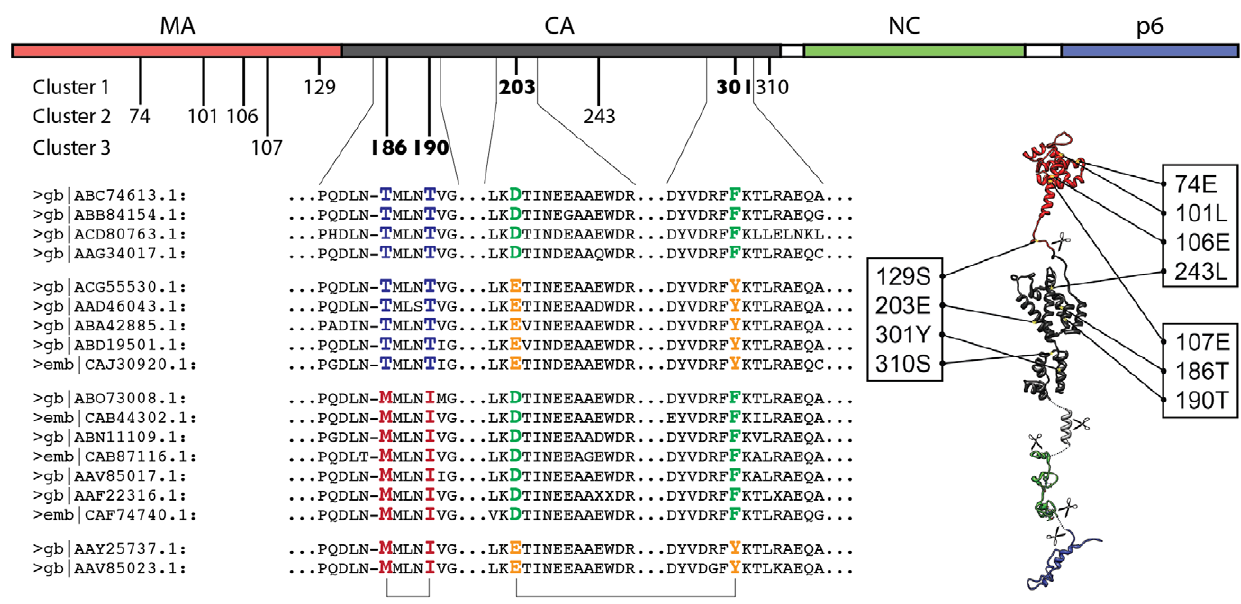
Figure 1. The location of the positions described in the text on Gag sequence and structure. The top shows a linear representation of Gag domain structure, with positions numbered according to GAG_HV1B1. The three non-trivial co-evolving clusters are shown beneath the domain structure, as are the appropriate regions of the alignment for a sub-set of the sequences used. Sequences are labeled by their GenBank (gb) or EMBL (emb) accession codes. The structures on the bottom right show where the positions in the figure lie on the known three-dimensional structures of Gag domains. The two most significant pairs are marked in the alignment.